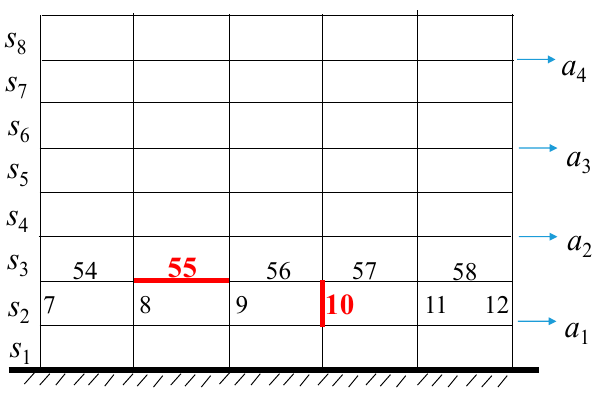
Figure 7. The location of 10 th column and the 55 th beam. Table 6. Damage identification results of 2 nd substructure with single column/beam damage.